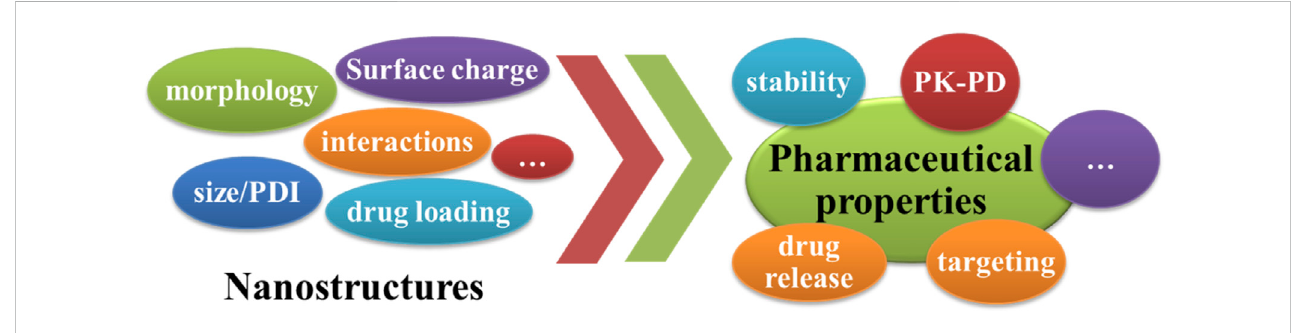
FIGURE 4 The nanostructures and pharmaceutical properties of zein-based